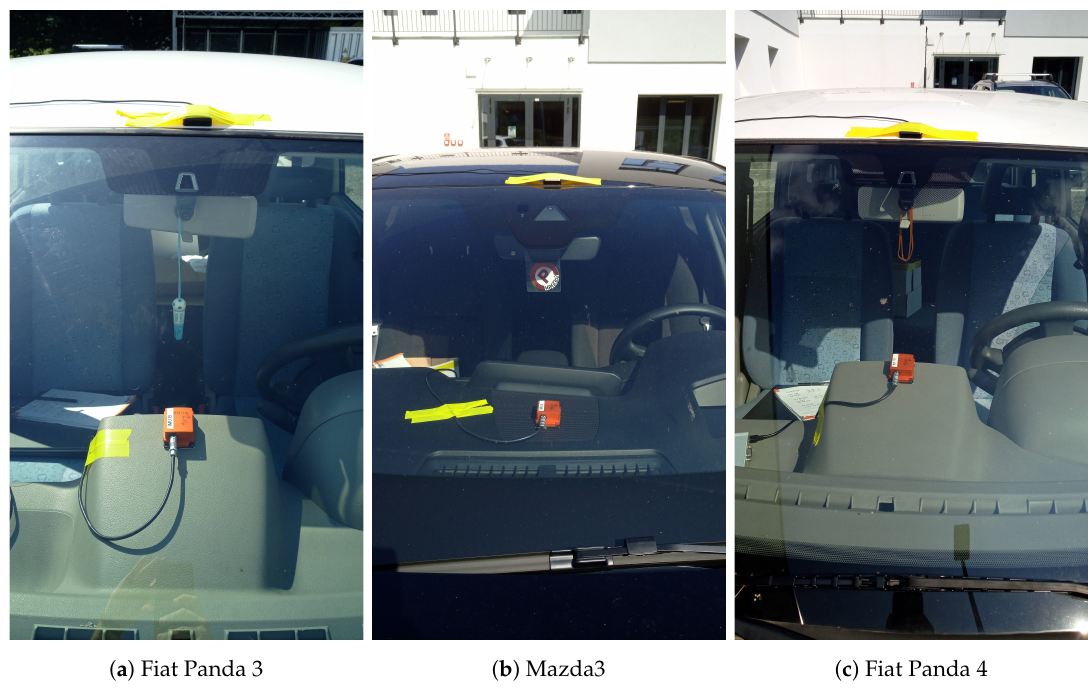
Figure 1. Placement of the sensor used for the data collection in the vehicles for three vehicle models.